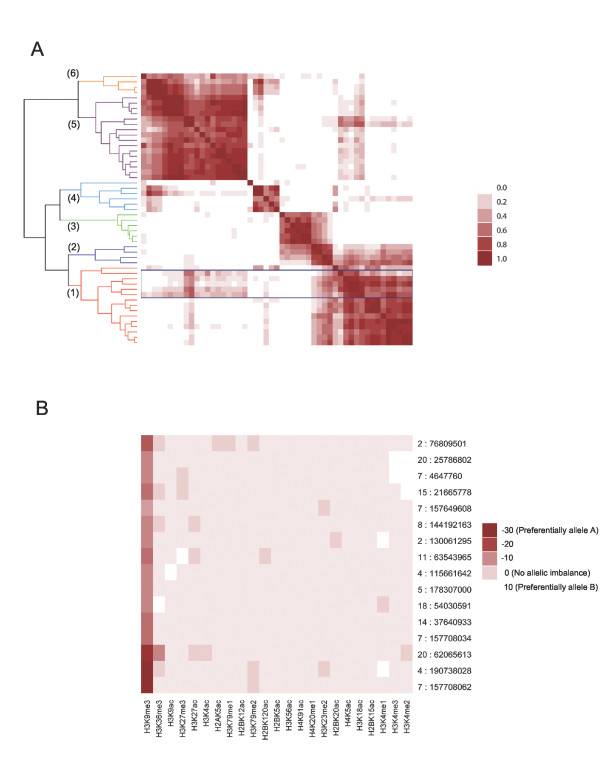
Clustering of significant sites of allele-specific histone modification in the H1 cell line by patterns of allele-specific modification. (A) All 51 significant sites clustered according to the allelic imbalance seen for each examined histone modification. The scale corresponds to the squared correlation of the observed allelic imbalances for each modification (as measured by the log of the respective binomial P-value) between corresponding pairs of sites. Sites showing the strongest evidence of being largely driven by H3K4me3 preferentially on one allele and H3K9me3 on the other are highlighted by the blue box (chr4:89004339, chr4:89004397, chr4:89004505, chr7:23729054, chr15:22751085). (B) Allelic imbalance for each histone modification at the sites forming cluster 5. Most modifications displayed no consistent evidence of allelic imbalance at these positions; however, H3K9me3 reads were found to preferentially contain allele ‘A’ at these sites (for this plot the allele chosen to be the ‘A’ allele at each site was the allele found more often in the H3K9me3 reads at each position).